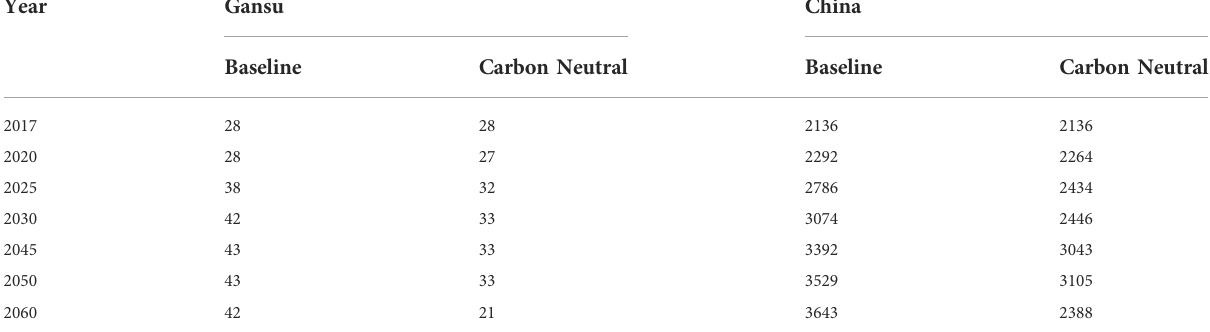
TABLE 3 Final energy demand projection in Gansu provinces and China from 2017 to 2060(unit:Mtoe).